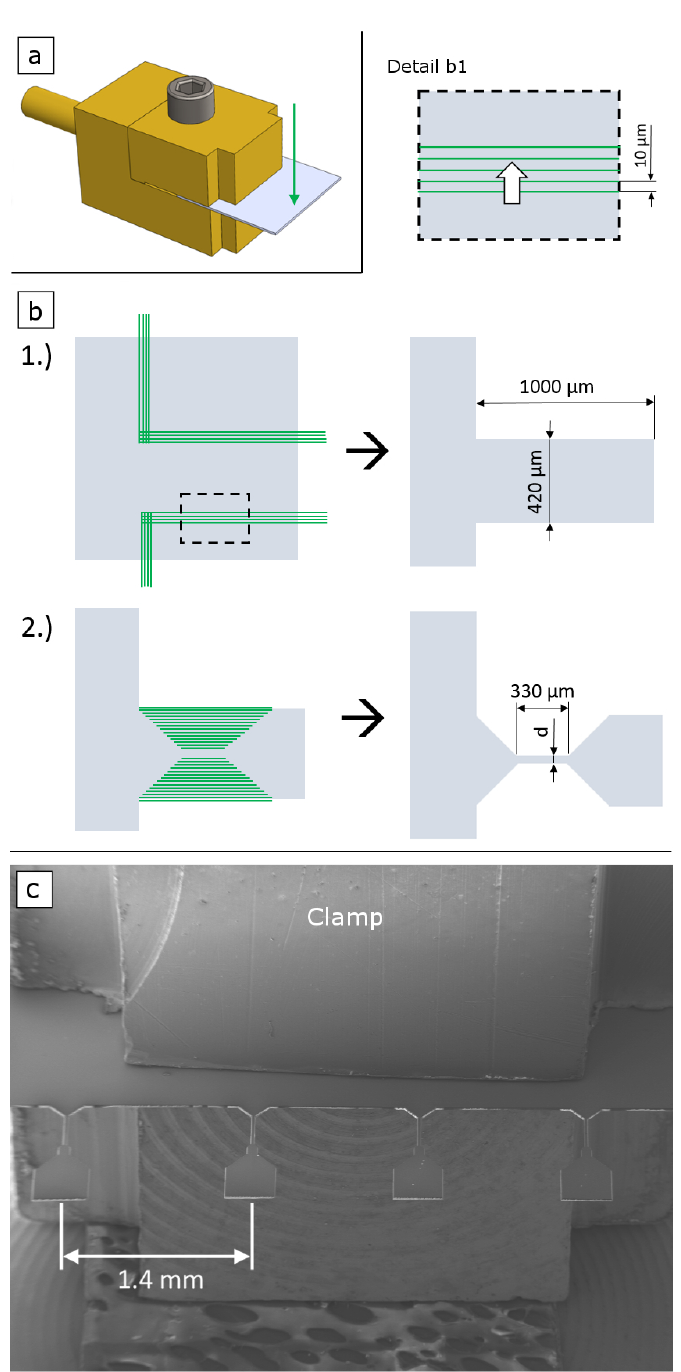
Figure 1. ( a ) 3D sketch of a foil fixed in a clamp with the VDA film on top. The arrow indicates the incidence direction of the laser beam. ( b ) Outline of the two step cutting process from the view of the laser incidence direction. First a rectangular shape with the intended width of the tensile head is cut. In the second step the dog bone shape is processed. Relevant dimensions of the specimen are given. The width d of the gauge section was about 100 µ m for the FEP VDA and about 25 µ m for the Upilex-S VDA foils. Detail (b1) displays the magnification of the dashed rectangle in step 1. Each laser scan line is shifted 10 µ m in the direction of the broad arrow. ( c ) SEM image showing a set of four samples cut in a Upilex-S VDA foil, fixed in the clamp for the following tensile